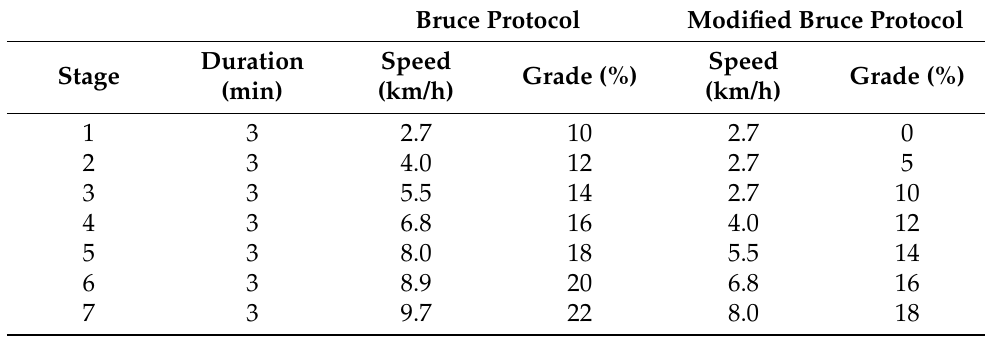
Table 1. Bruce protocol and modified Bruce protocol for